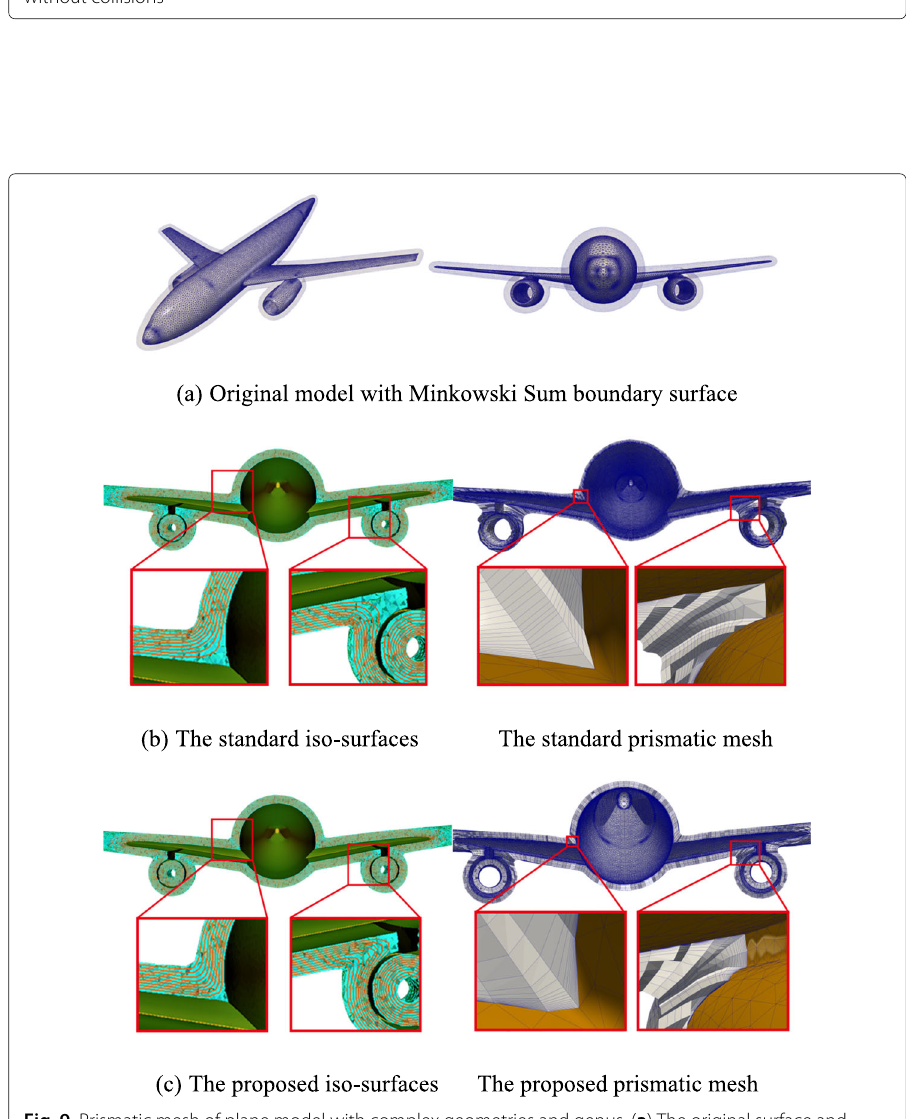
Fig. 9 Prismatic mesh of plane model with complex geometries and genus. ( a ) The original surface and envelope surface; ( b ) and ( c ) The iso-surfaces and prismatic meshes generated using the standard harmonic field and the proposed anisotropic harmonic field,